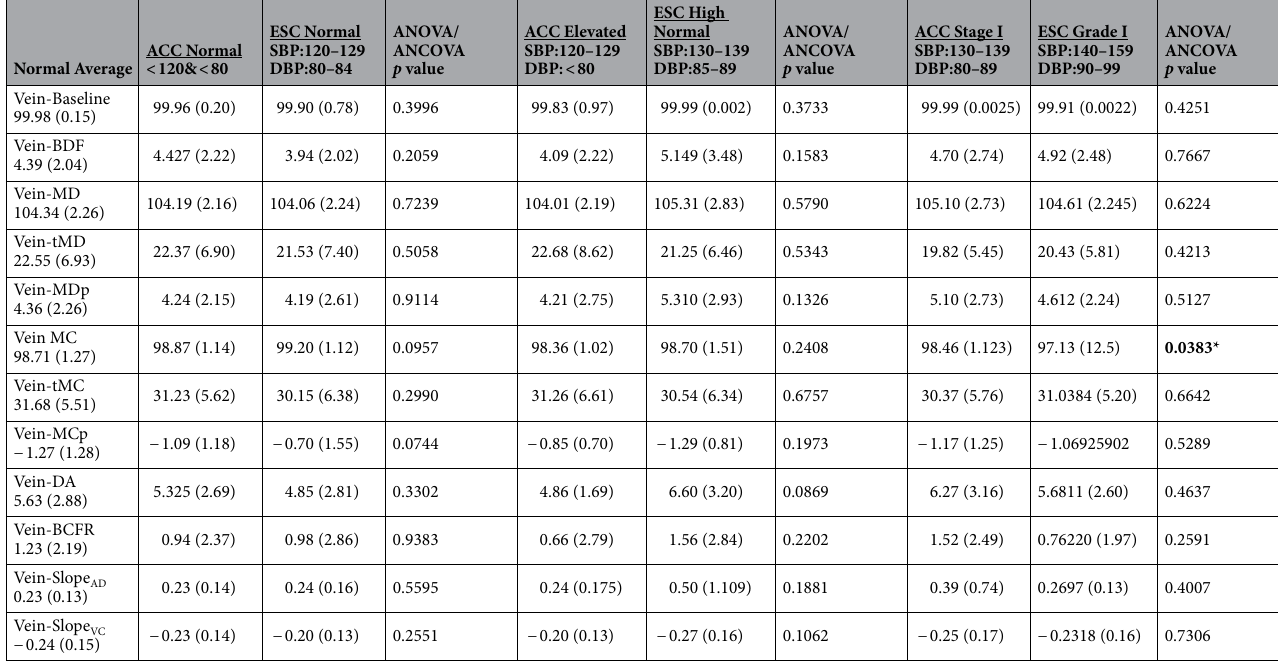
Table 3. Summary of retinal arterial vascular function parameters. Abbreviations ANOVA, analysis of variance; ANCOVA, analysis of covariance; Baseline, baseline diameter; BDF, baseline diameter